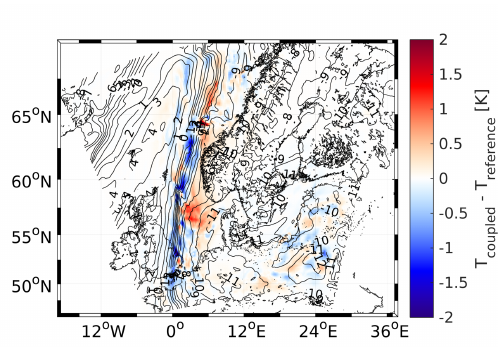
Figure 14. Absolute values of the temperature at the 850 hPa geopotential height in the reference model simulation (contours) and the differences in the temperature between the coupled and reference model simulations (shaded) on 16 January 2017 at 6:00 a.m.